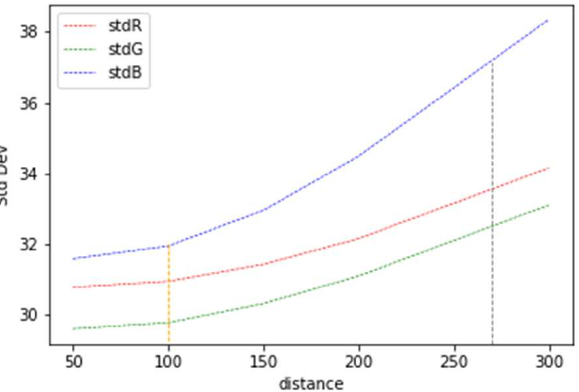
Figure 5. Primitive mask and the optimum value of the buffer distance for the road dataset.